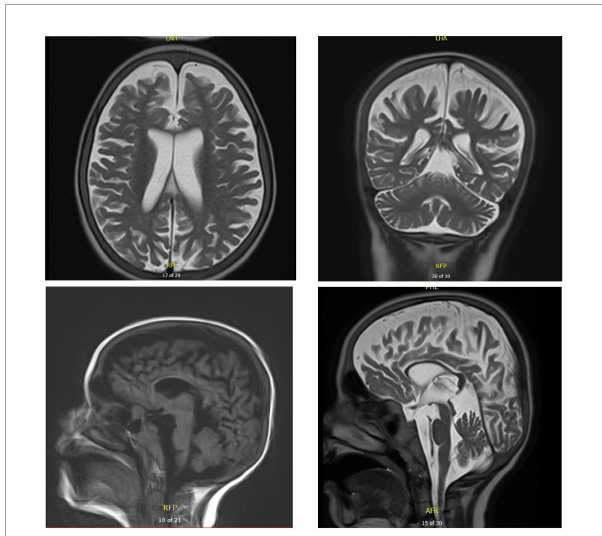
FIGURE6 Brain MRI of patient five at the age of 17 years. T2 axial and coronal MRIs show general atrophy with normal white matter signal. Sagittal T1 and T2 brain MRIs show supra- and infratentorial cerebral atrophy, with marked thinning of the corpus